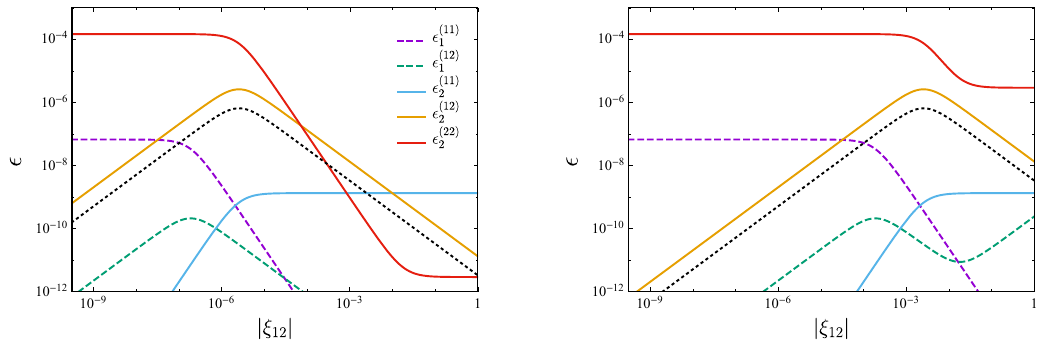
Figure 4 . A typical behavior of various asymmetry parameters. The approximate formulae of these parameters are given in the text. (Left) | ξ = 10 − 5 and | ξ = 10 − 3 . (Right) | ξ = 10 − 2 11 | 22 | 11 | and | ξ = 1 . In these figures, the neutrino Yukawa couplings are roughly replaced by the mass 22 | eigenvalues of neutrinos as ( y ν y ν † ) ( m ) 1 / 2 /v 2 , and the complex phases of couplings ij ∼ N i m N j m ν i m ν j are assumed such that the asymmetry parameters take their maximal values. For comparison, the (˜Γ relative size of asymmetry parameter for the two-body decay ˜ (cid:15) Γ ) is shown by the black 2 2 / 2 dotted